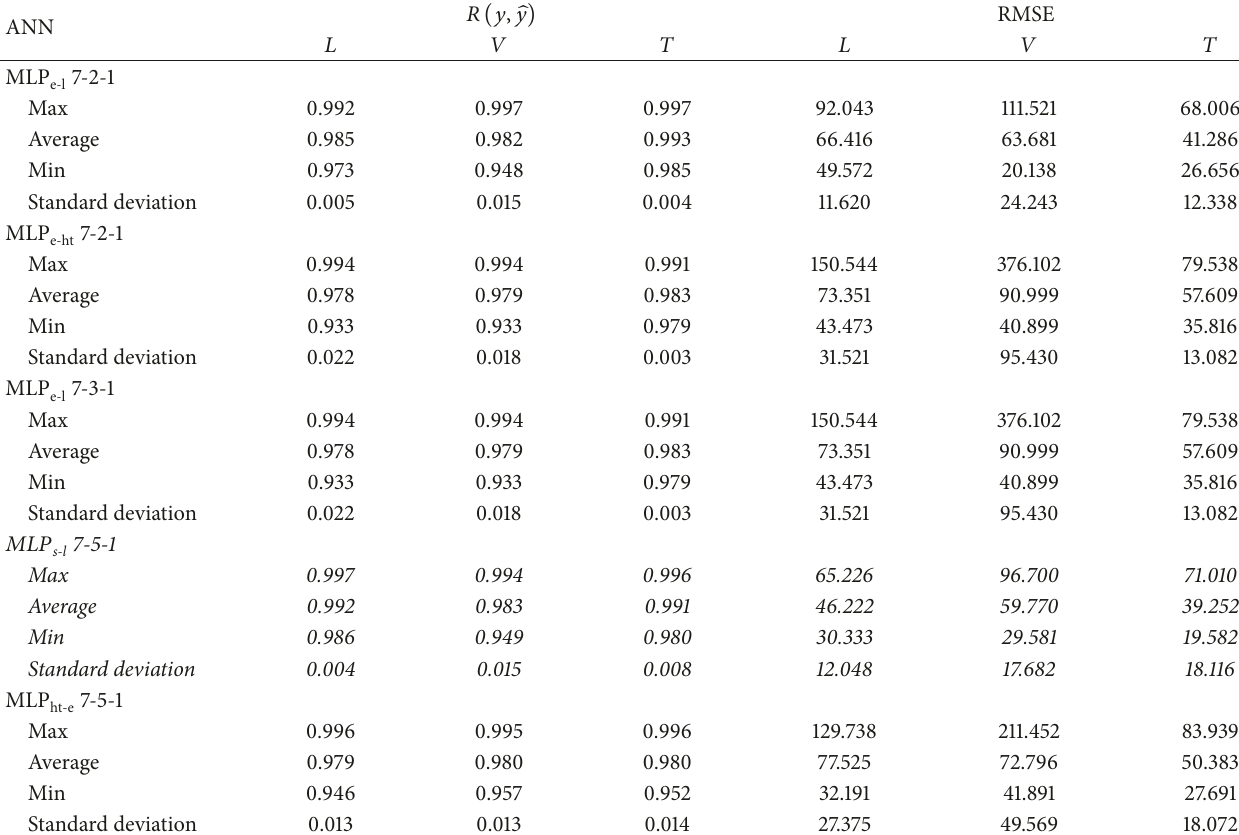
Table 8: Results of the selected ANNs training (source: own study).